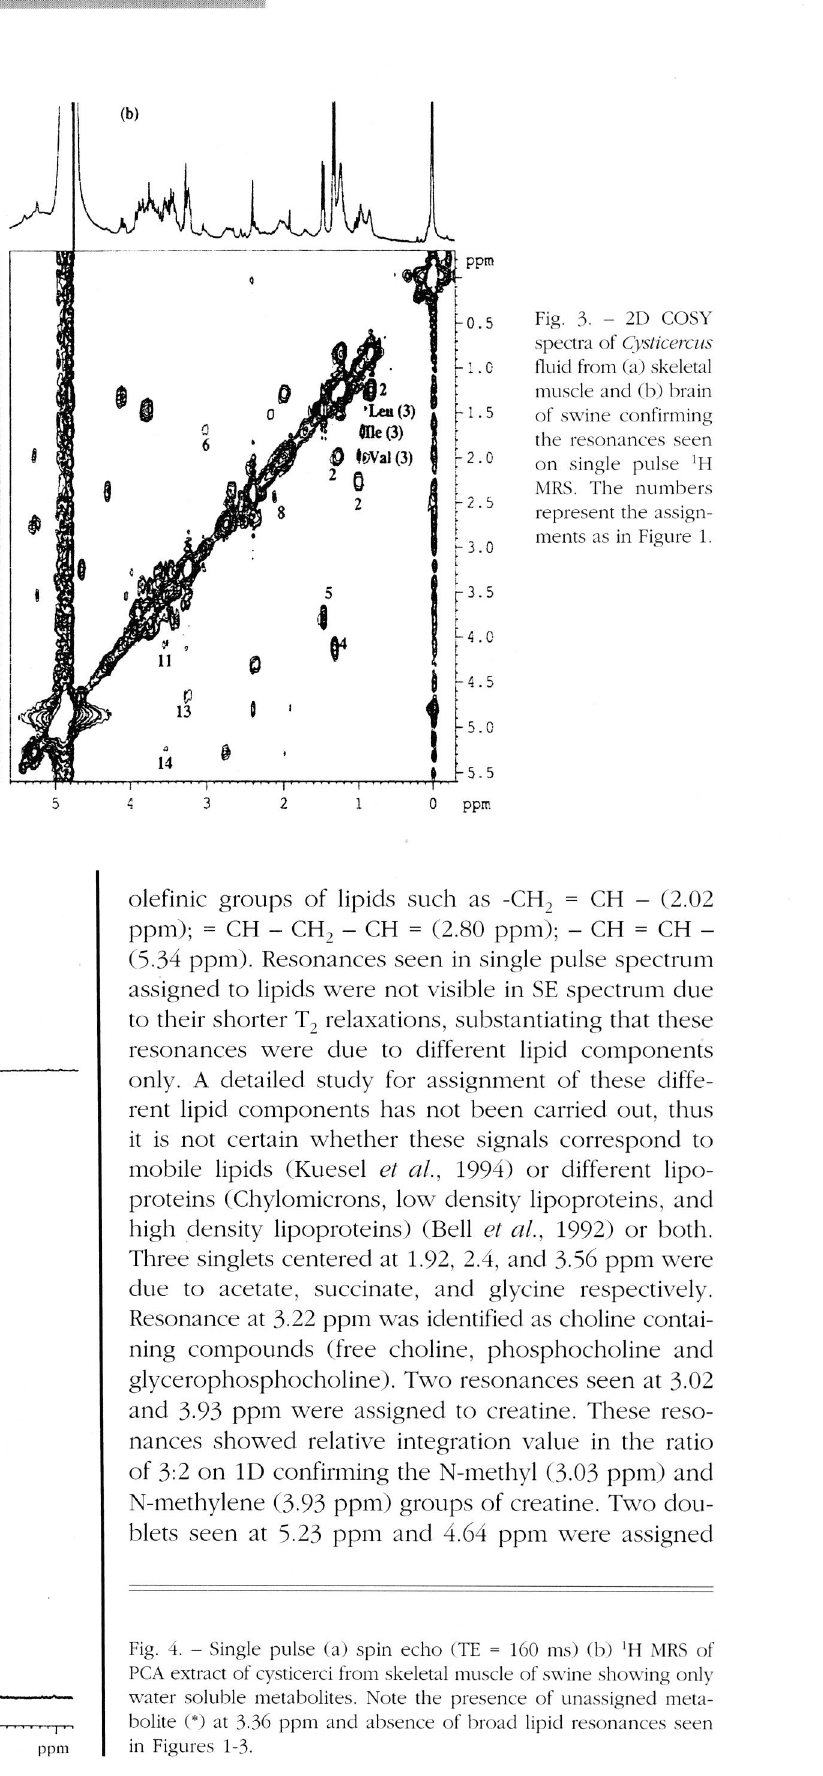
Fig. 4. - Single pulse (a) spin echo (TE = 160 ms) (b) 1 H MRS of PCA extract of cysticerci from skeletal muscle of swine showing only water soluble metabolites. Note the presence of unassigned meta bolite (*) at 3.36 ppm and absence of broad lipid resonances seen in Figures